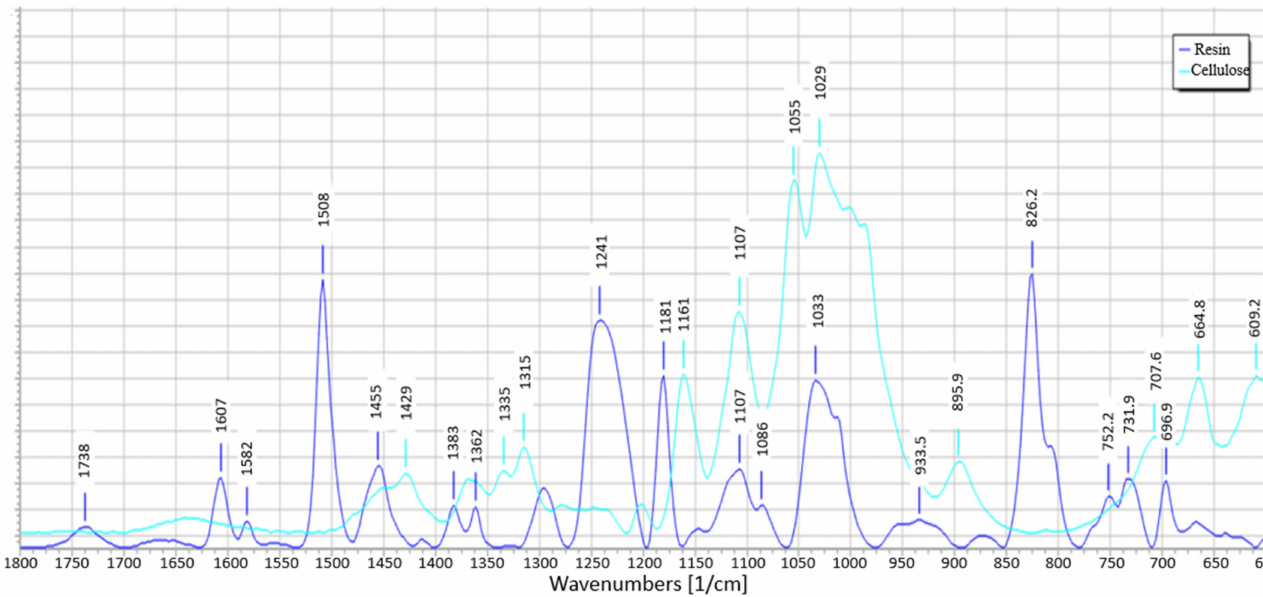
Figure 21. IR spectra of samples with epoxy resin matrix modified with natural additives (upper plot with range of 4000–1800 1/cm, lower plot with range of 1800–600 1/cm.